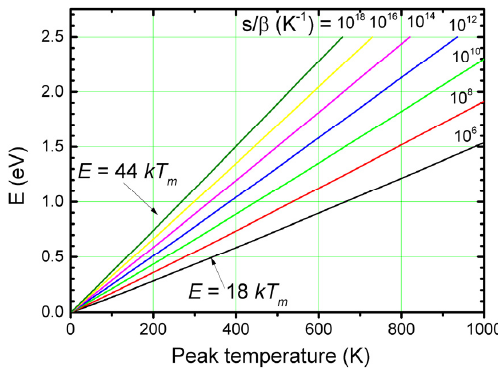
Figure 4. Trap depth E calculated with Equation (6) as a function of the peak temperature for a wide range of values of the ratio s / β .